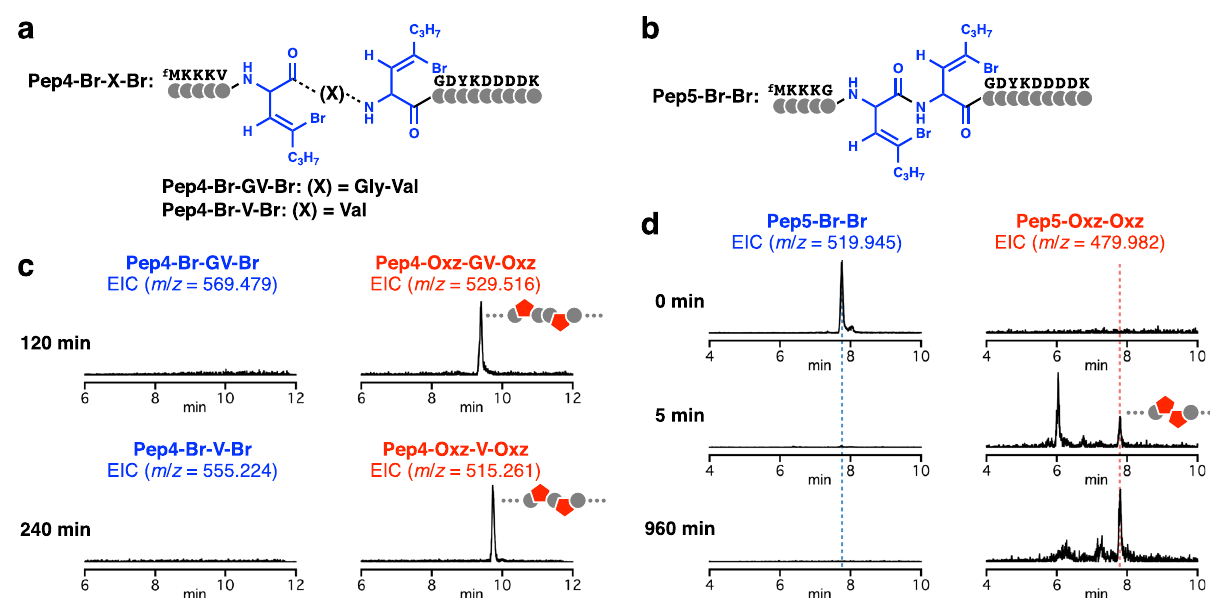
Fig. 4 Synthesis of peptides containing multiple oxazoles. a Sequences of Pep4-Br-X-Br containing two BrvG residues separated by different spacer regions (X). b Sequence of Pep5-Br-Br containing two successive BrvG residues. c , d Synthesis of peptides containing two oxazole moieties. EICs of m / z values corresponding to the precursors and the expected products with two Oxz are shown. Additional EICs used to monitor these reactions are shown in Supplementary Fig.